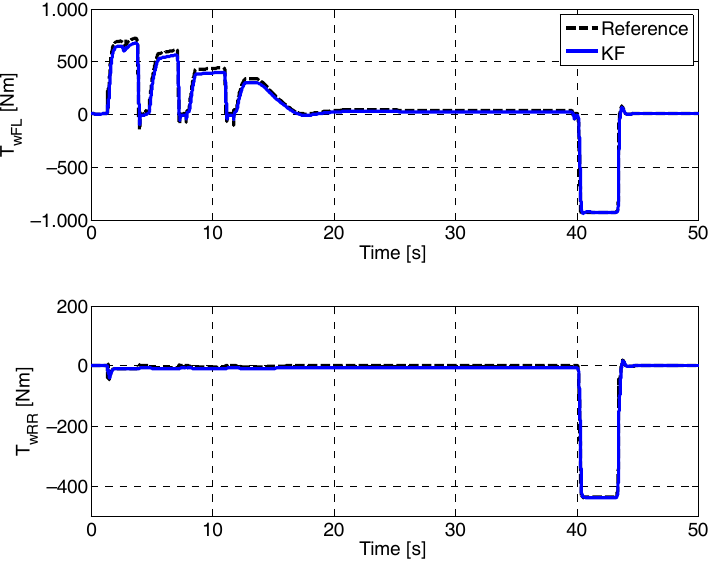
Figure 13. Comparison between the simulated wheel torque in IPG CarMaker (Reference) and the observed value (KF) for the front left wheel ( above ) and the rear right wheel ( below ).